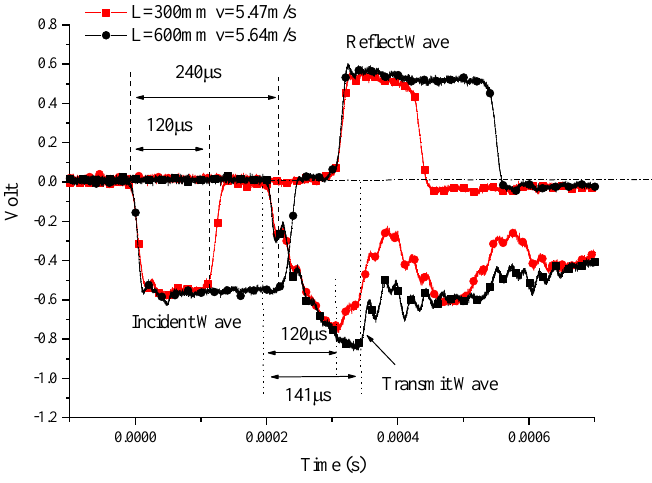
Figure 10. Effect of bullet length of 45° SCSs.